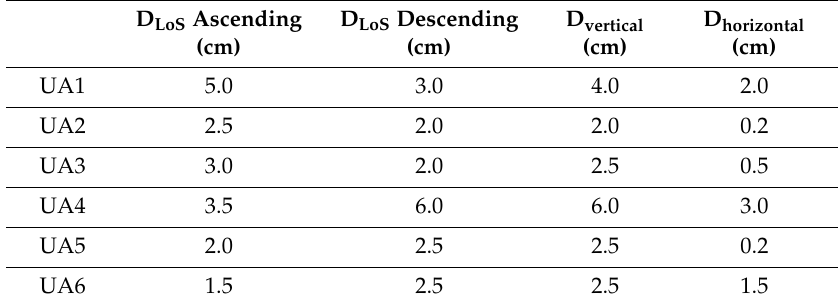
Table 3. Line of sights (LoS), vertical and horizontal displacement components for ascending and descending orbits. (Incident angle: 34 ◦ ascending; 43 ◦